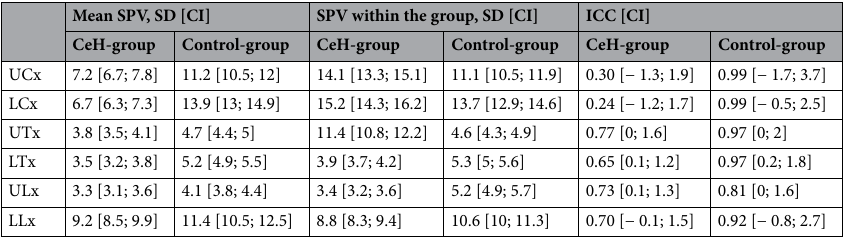
Table 3. Spinal postural variability and ICC in the CeH-group and control-group.